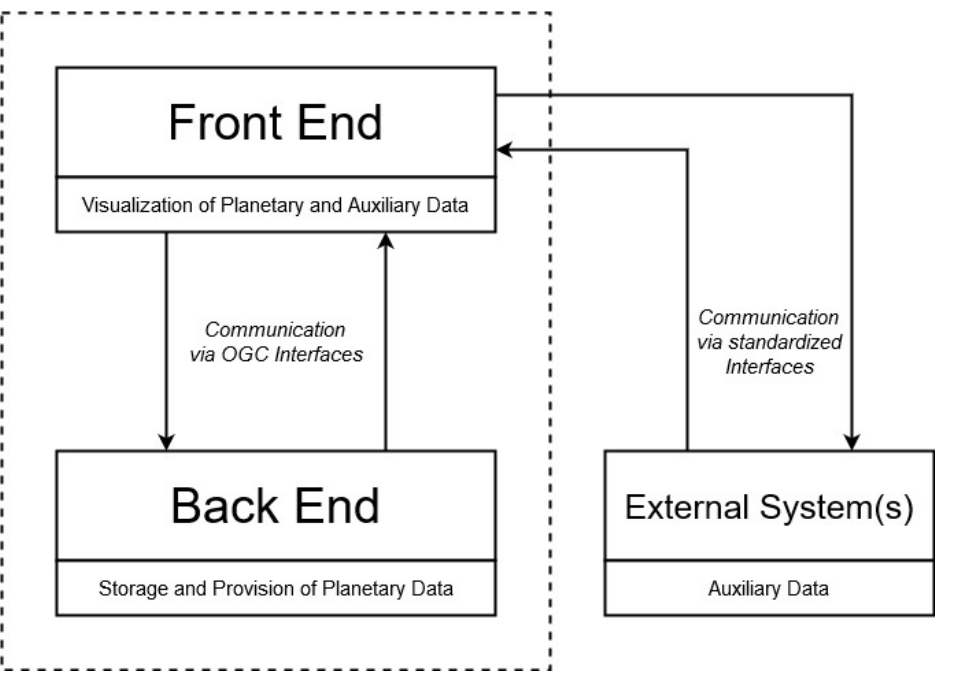
Figure 3. Simplified two-tier system architecture: A graphical user interface displays data pro- vided by the backend via OGC interfaces. Furthermore, external systems can be connected via standardised